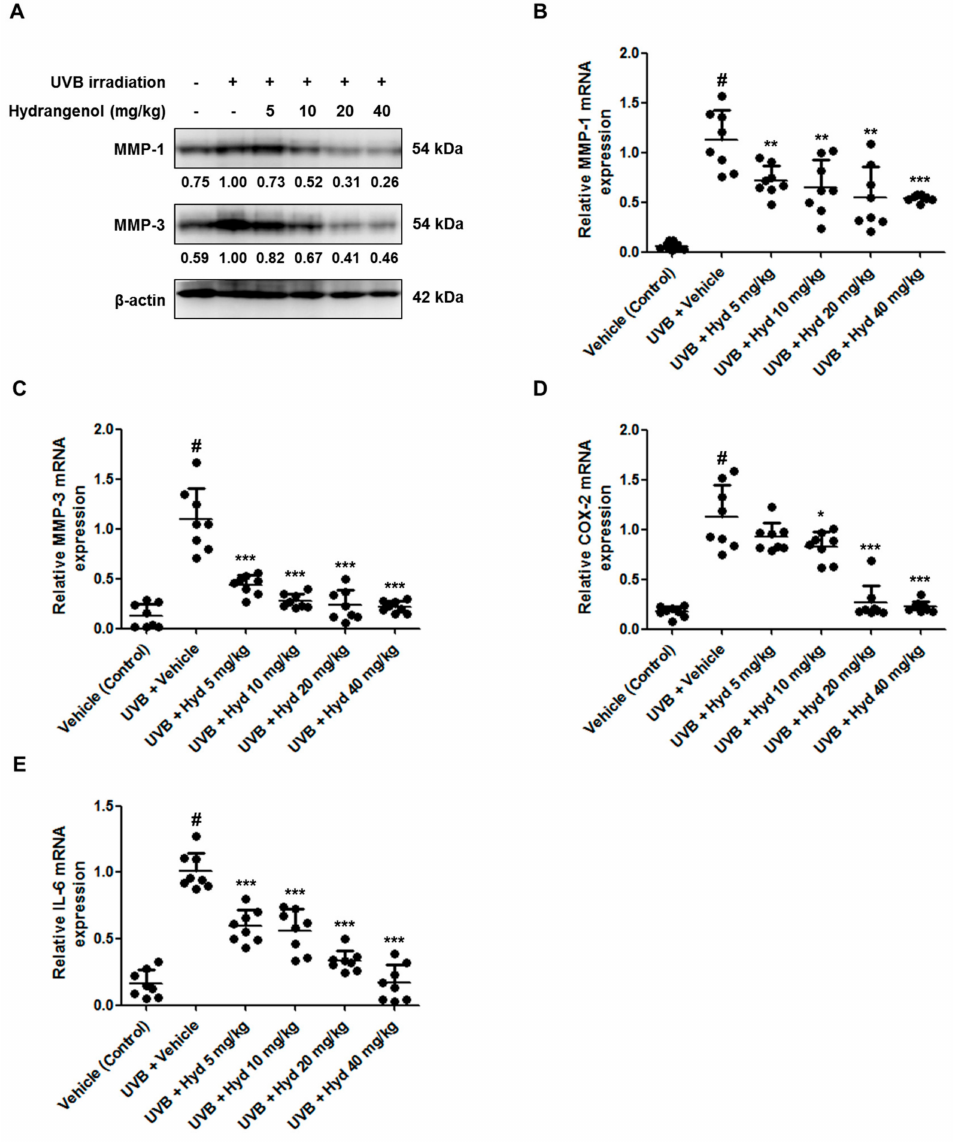
Figure 6. E ff ects of oral administration of hydrangenol on matrix metalloproteinase (MMP)-1 / -3, COX-2, and IL-6 expression in UVB-irradiated hairless mice. HR-1 hairless mice were administered hydrangenol (5, 10, 20, or 40 mg / kg) daily for 7 weeks of exposure to UVB. Total proteins and RNA were extracted from dorsal skin tissues. ( A ) The protein expression of MMP-1 and MMP-3 were estimated by Western blotting using specific MMP-1 and MMP-3 antibodies. The internal control was a β -actin protein. Each band is representative of three experiments. ( B , C ) The mRNA levels of MMP-1 / -3, ( D , E ) COX-2, and IL-6 were analyzed by qRT-PCR. Values are expressed as means ± SD ( n = 8). # p < 0.05 vs. the vehicle-treated control group; * p < 0.05, ** p < 0.01, and *** p < 0.001 as compared to the UVB + vehicle-treated